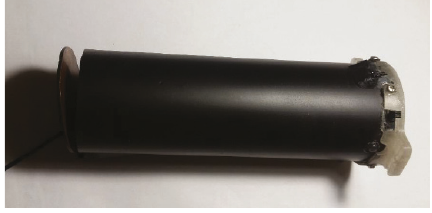
Figure 11: Parachute system body.